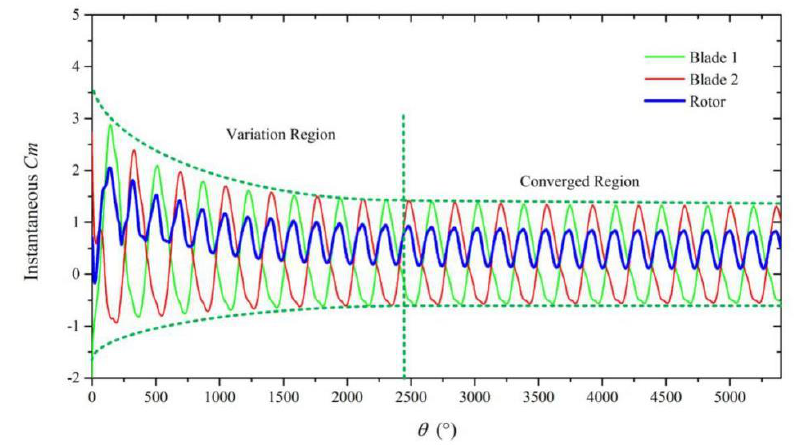
Figure 5. The torque coefficients during 15 rotation periods for the case of l = 1.5 D , φ = 45 ° and TSR = 1.